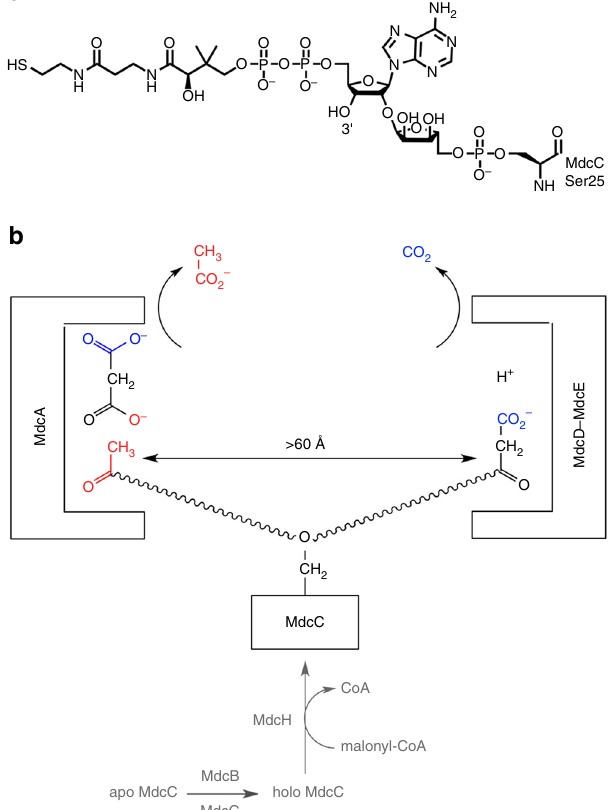
Figure 1 Reactions catalyzed by the malonate decarboxylase (MDC) system. a Chemical structure of the 2 ′ -(5 ′′ -phosphoribosyl)-3 ′ -dephospho- CoA prosthetic group for the acyl-carrier protein (MdcC) in malonate decarboxylase. b Malonate decarboxylase contains two distinct active